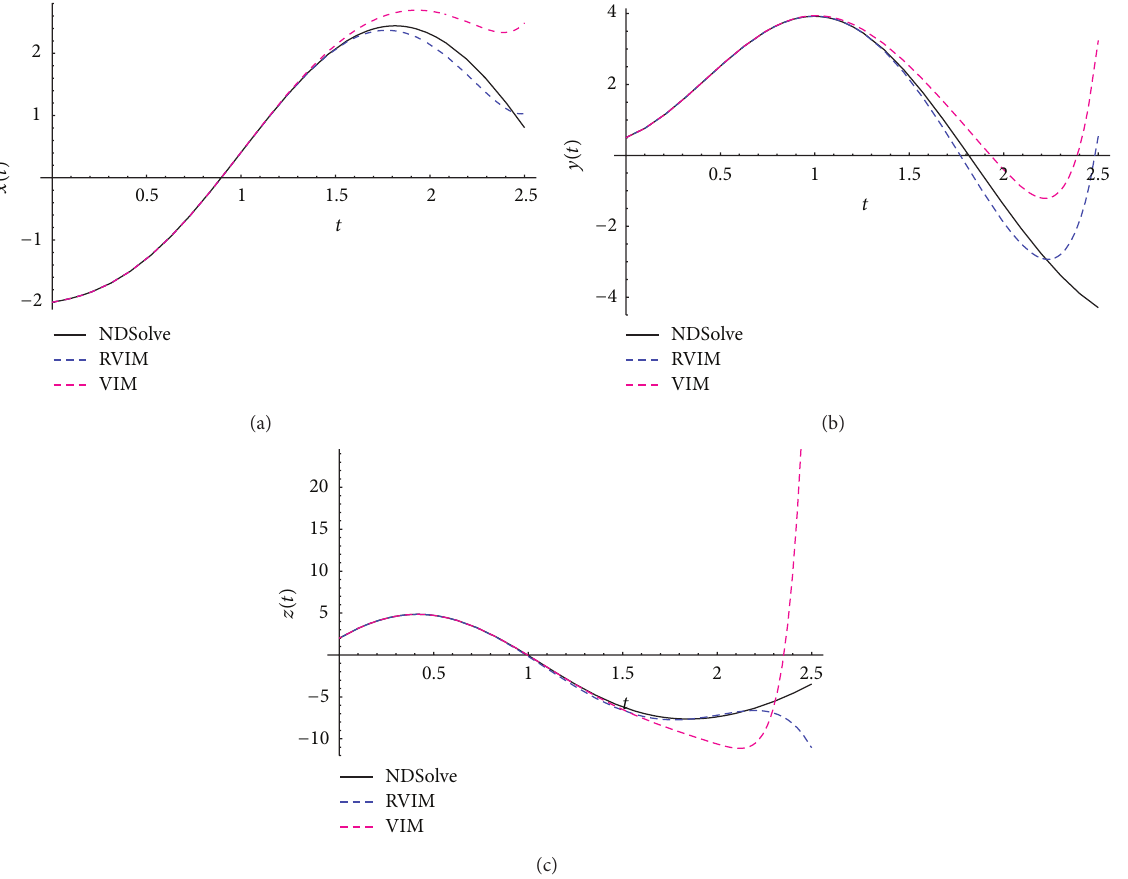
Figure 5: Simulation of the approximate results for 𝛼 1 = 𝛼 2 = 𝛼 3 = 1 and exact results of the Genesio-Tesi system for parameters 𝛽 1 = 6.5 , = 2.92 , 𝛽 = 1.2 , and 𝛽 = 1.0 . 𝛽 2 3 4